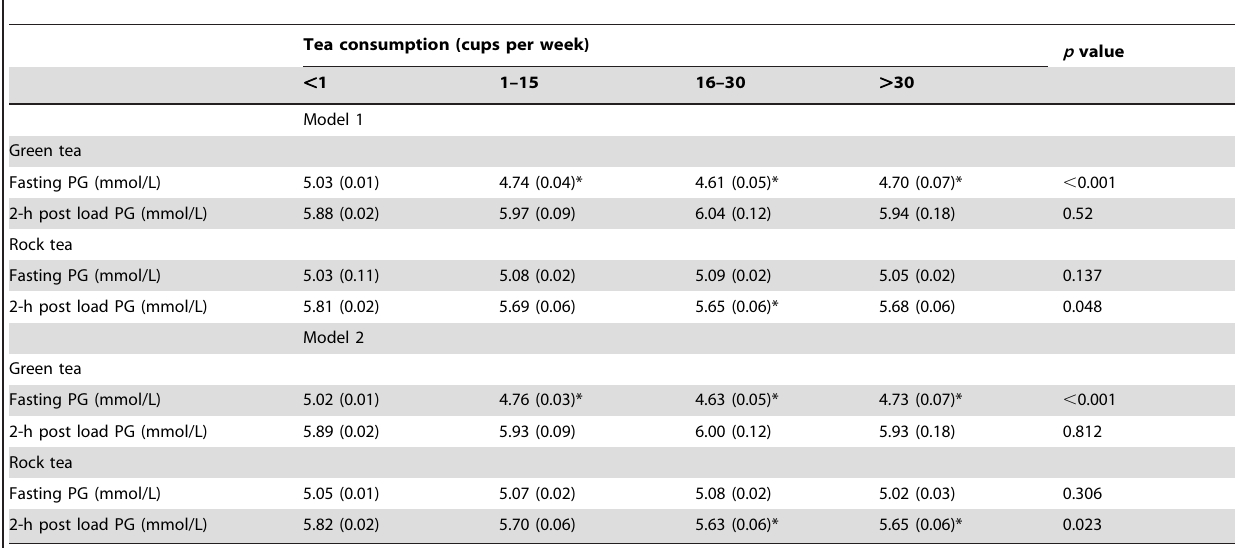
Table 3. Plasma glucose concentrations grouped according to weekly consumption of green tea or rock tea.